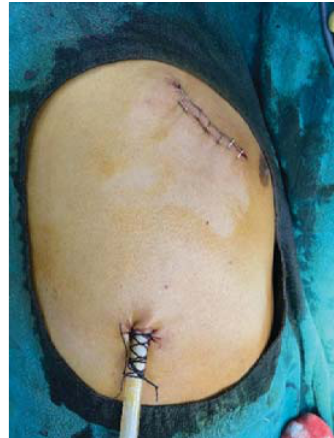
Figure 5. Post-opeative scar and